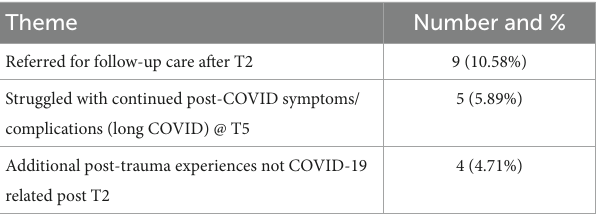
Table 7 highlights qualitative data related to the research participants which focused on the drop-outs from the study. Each participant was followed-up and offered further support and intervention. As their withdrawal impacted upon the T2 – T5 psychometric data their data removed from the overall data set. Although a 10.58% drop-out rate is low it is also reasonable to assume that not every client, once they have direct experience of working in this way, will find it useful.